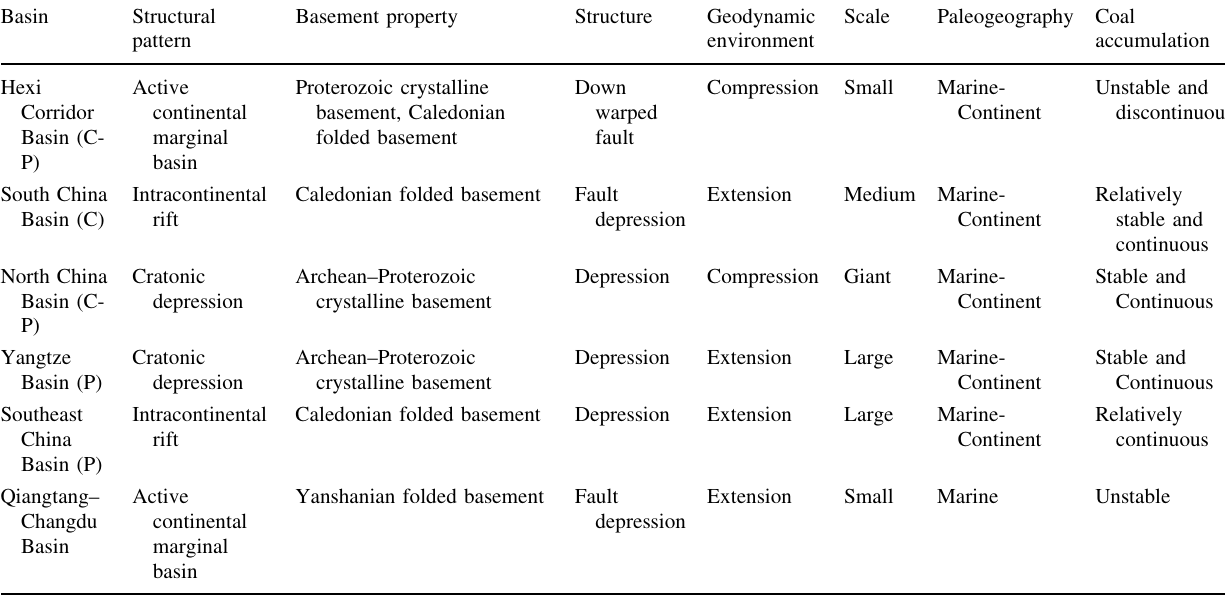
Table 3 Comprehensive types of coal-forming basins in the Late Paleozoic